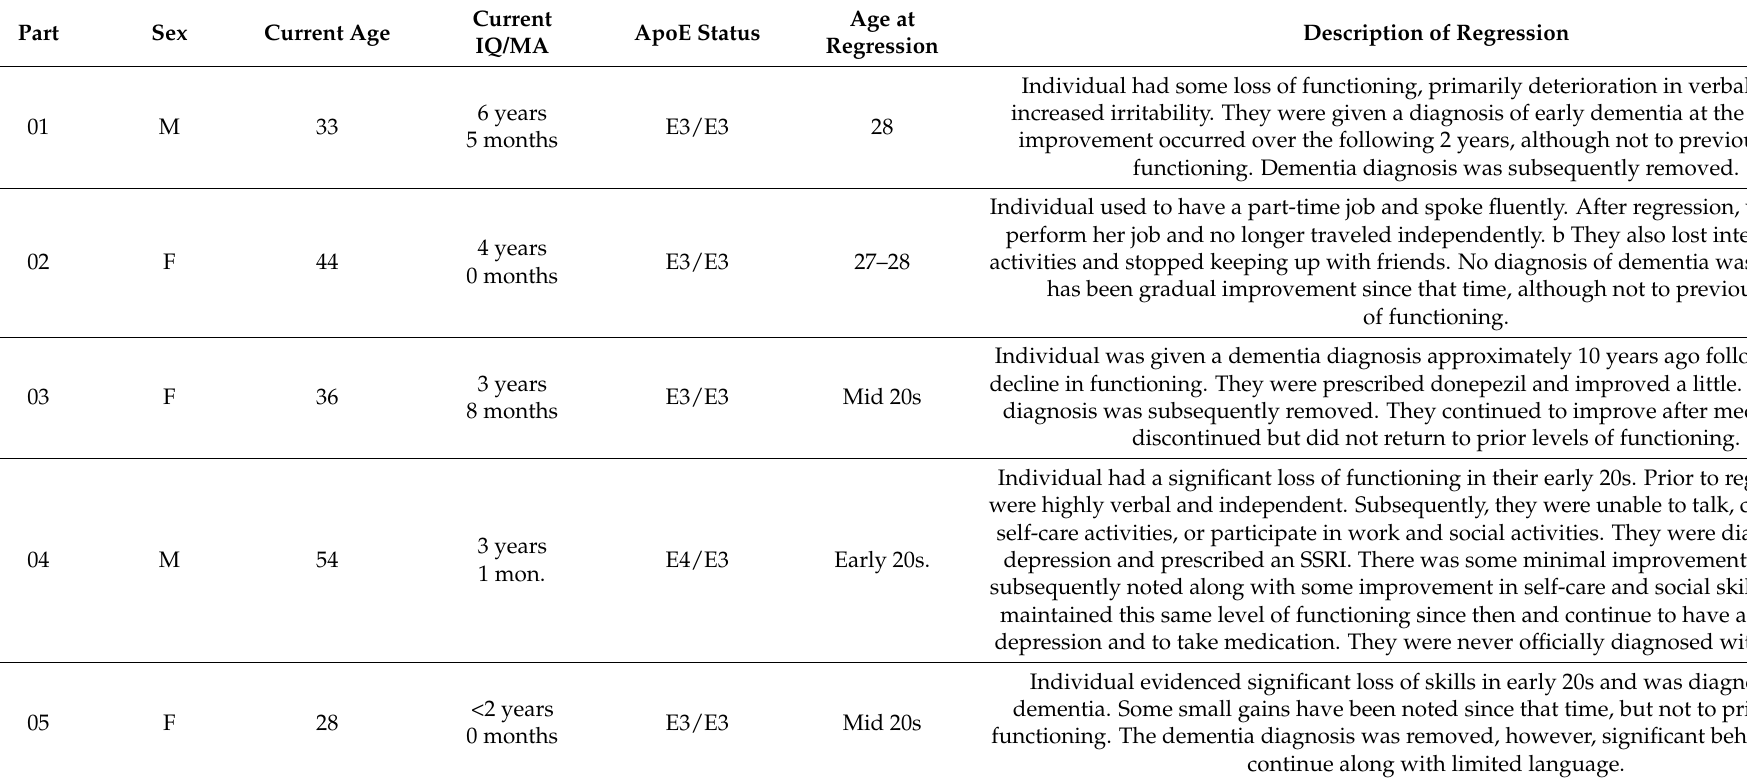
Table 1. Description of